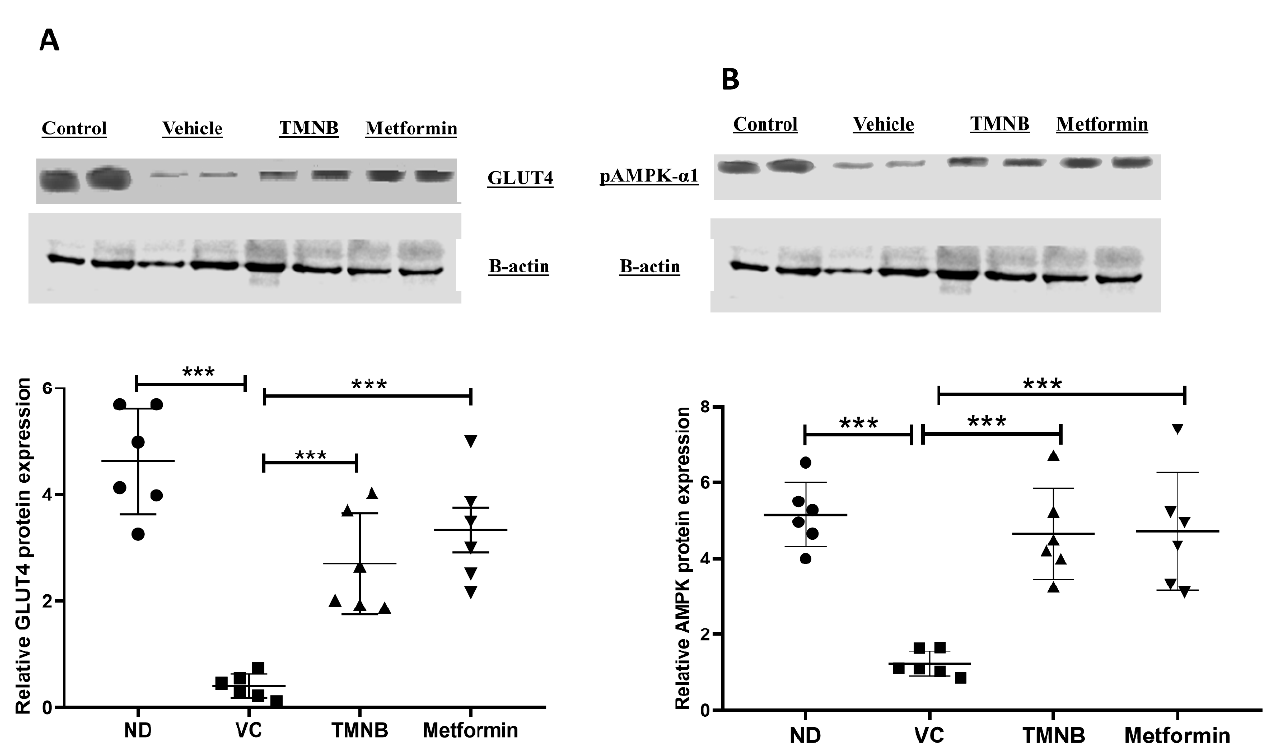
Figure 3. 2 ′ ,3,3,5 ′ -Tetramethyl-4 ′ -nitro-2 ′ H-1,3 ′ -bipyrazole upregulated GLUT4 and AMPK expres- sion in soleus muscle. TMNB significantly upregulated GLUT4 ( A ) and AMPK ( B ) expression within soleus muscle in diabetic rats. Rats were fed HFD for 3 weeks, followed by a single dose of STZ injection (40 mg/kg); once diabetes was confirmed, rats were treated with 10 mg/kg TMNB or 200 mg/kg metformin for 10 days. After the end of the experiment following euthanasia, soleus muscle was isolated and homogenized for downstream western blotting. One-way ANOVA was followed by Tukey post-hoc multiple comparison test, *** < 0.001. ND; non-diabetic, VC; vehicle control,